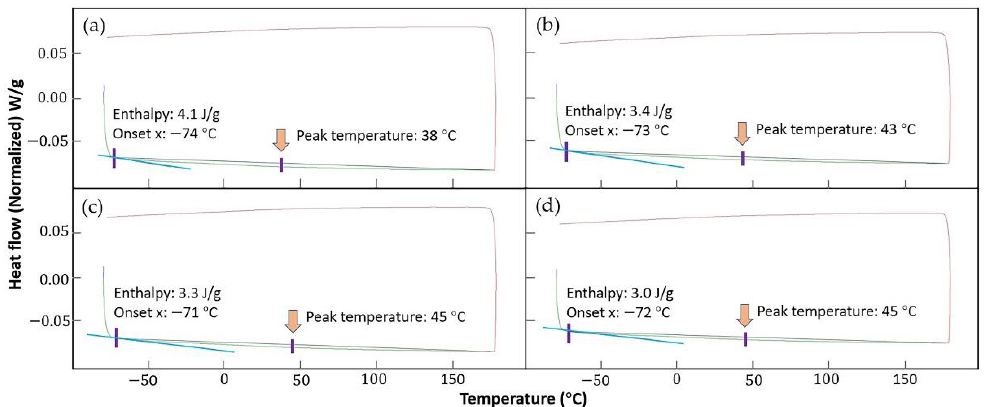
Figure 9. Integral calculation of the phase-transition enthalpy with TA Instruments software TRIOS based on the coating DSC curves: ( a , b ) before annealing; ( c , d ) after